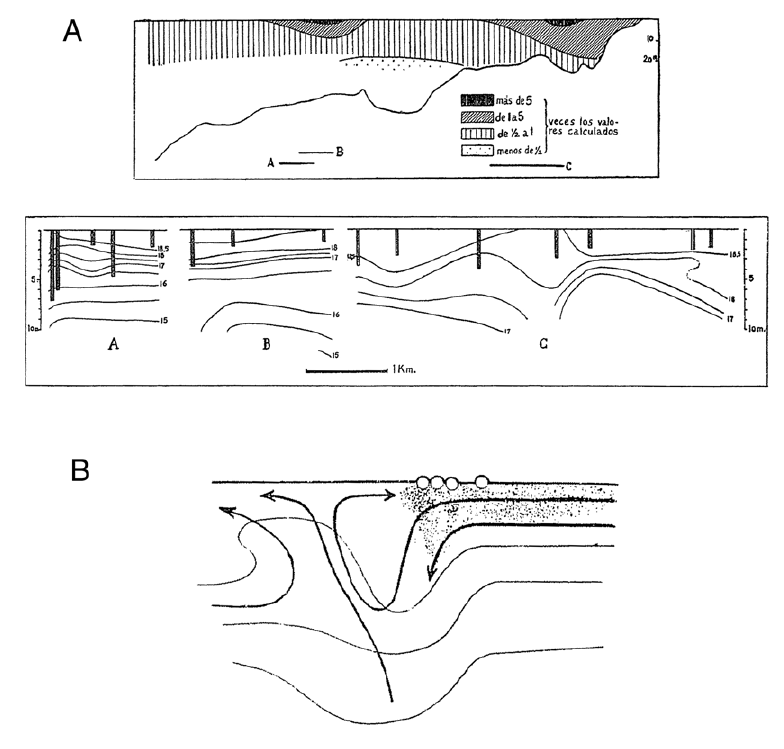
Fig. 6. – A: Spatial cell concentration during a red tide along the longitudinal axis of the Ria of Vigo. B: The origin of the sharp borders in a red tide patch, and the formation of foam as a consequence of a horizontal swirl (Margalef